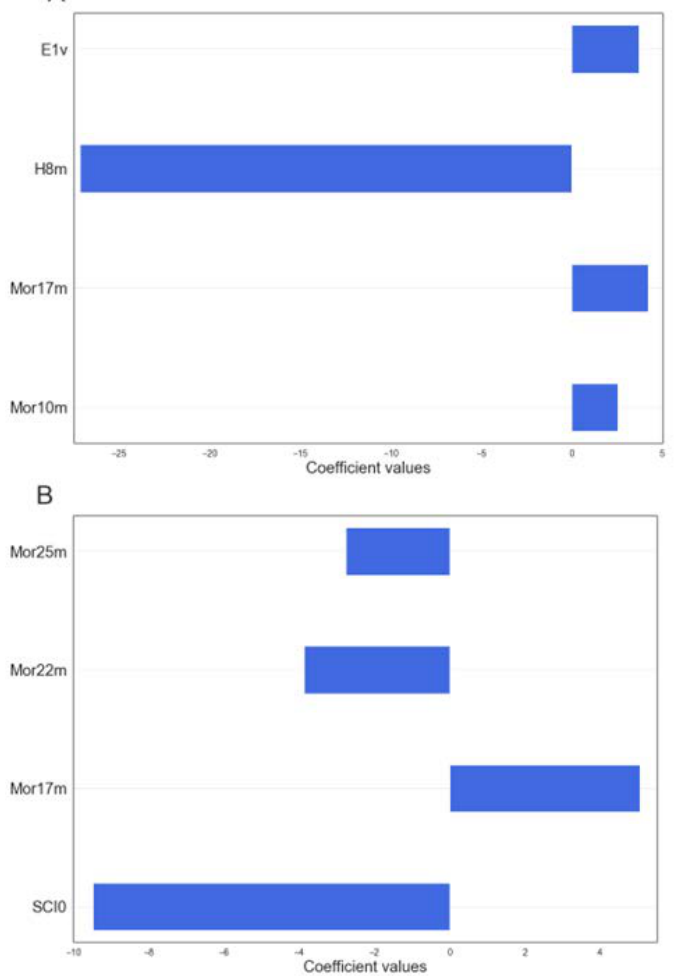
Figure 3. The relation between the descriptors and the rate of hydrolysis for ( A ) QPON1 by Equation (3) and ( B ) RPON1 by Equation